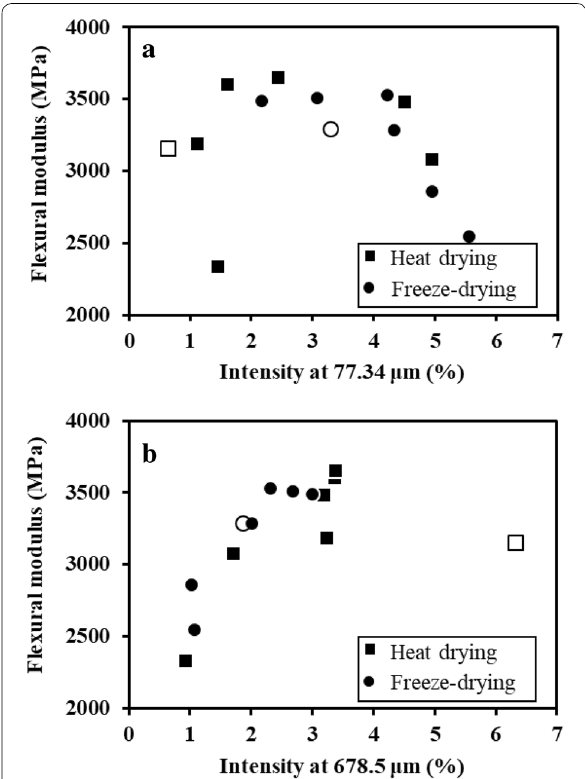
Fig. 7 The relationship between flexural modulus of WPC and intensity of the particle size distribution analysis at a 77.3 µm and b 678.5 µm. Open square, heat drying 0 min and open circle, freeze-drying 0